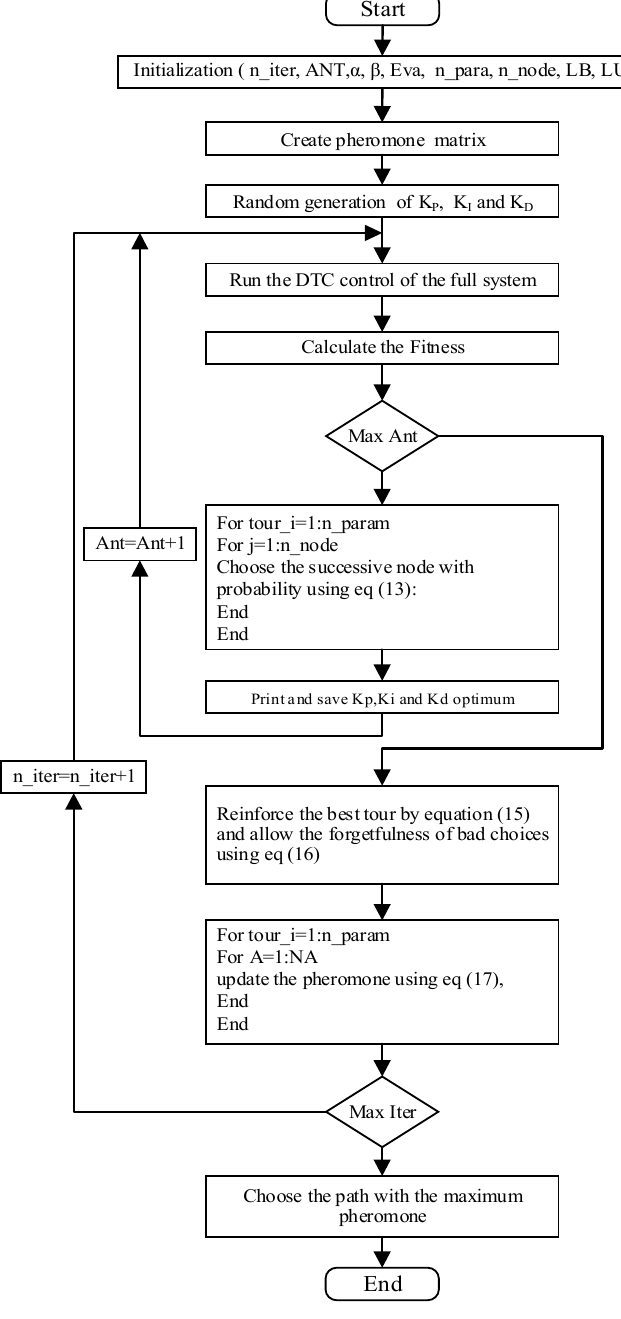
Figure 9. Flowchart of ACO algorithm for PID Controller Optimization.